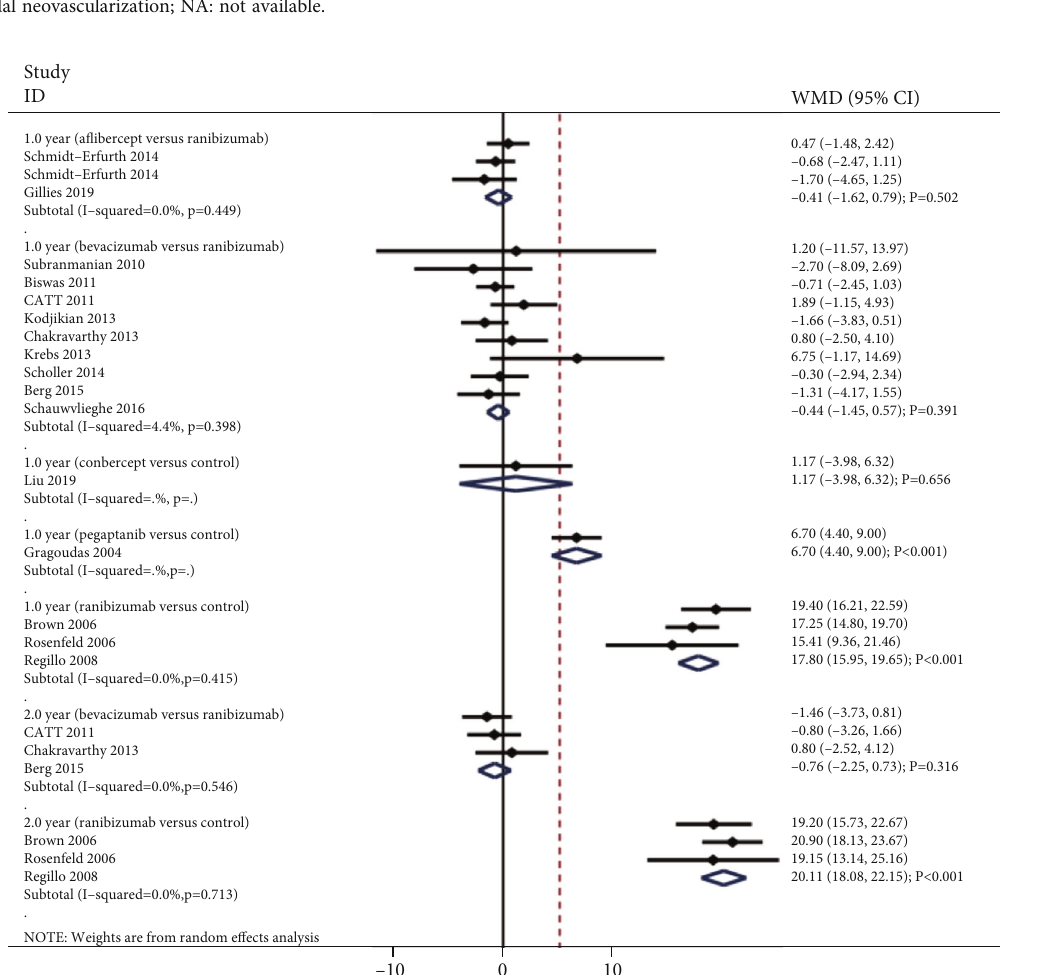
Figure 2: E ff ect of anti-VEGF inhibitors on the change of